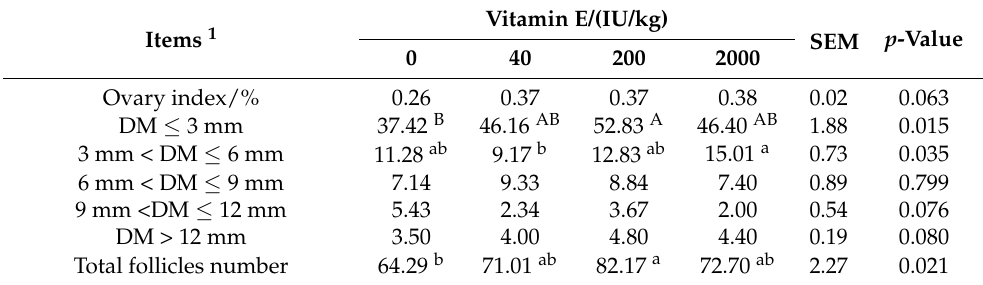
Table 3. Effects of dietary vitamin E supplementation on follicular development in breeding geese.